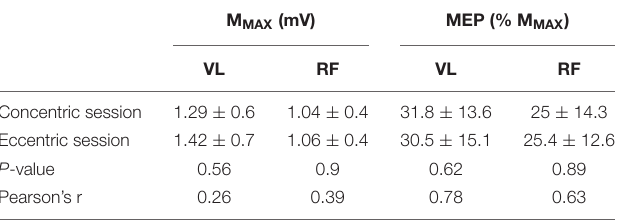
TABLE 1 | Muscle and corticospinal excitability per session prior to the 30-min bouts.